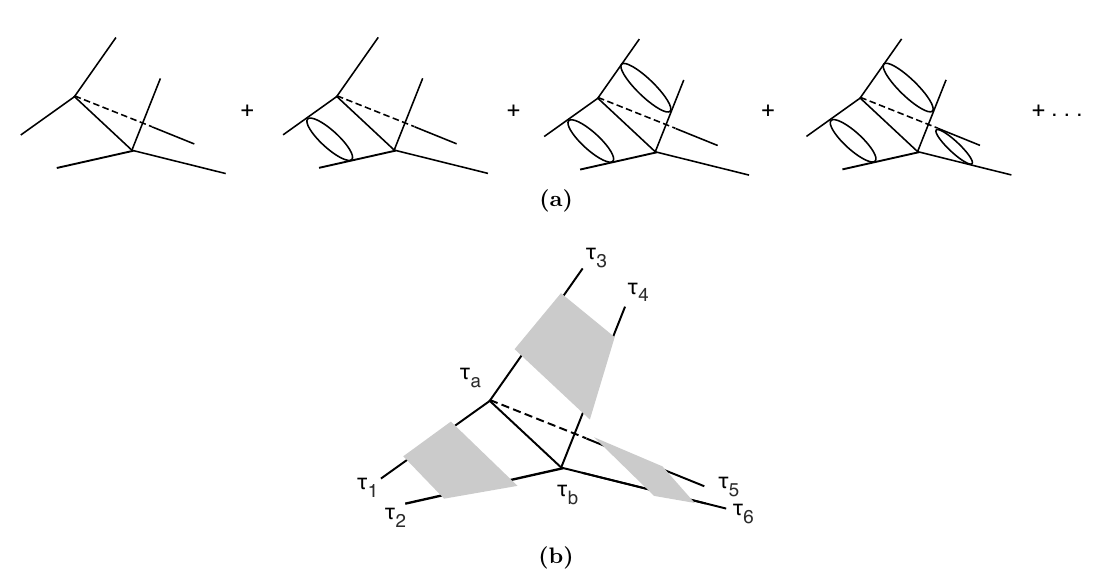
Figure 5. The (cid:12)rst set of diagrams (\contact" diagrams) contributing to the six-point function at order 1 =N 2 . (a). These diagrams can be compactly drawn as three four-point functions (shaded squares) glued together as in (b).